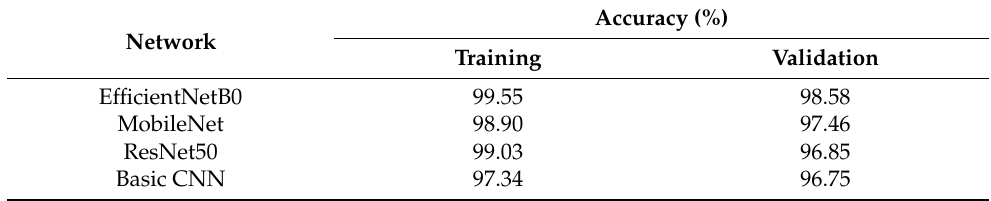
Table 4. Performance of pretrained deep-learning network for 2D grayscale-image PQD